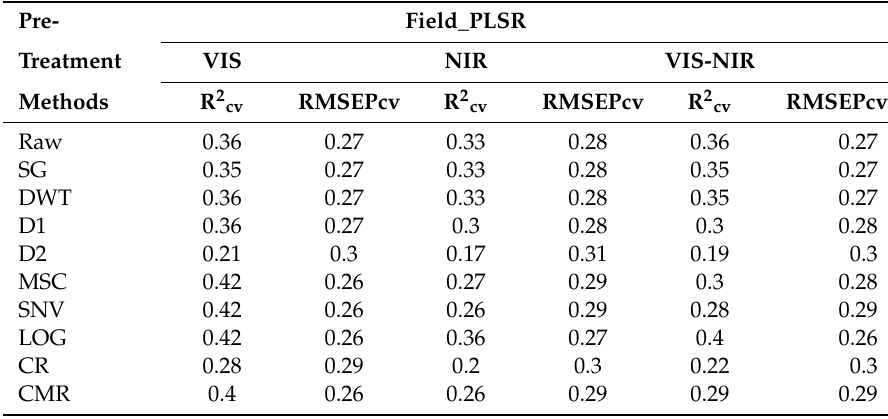
Table 2. Statistics of the five fold leave-group-out cross validation for field spectra using both